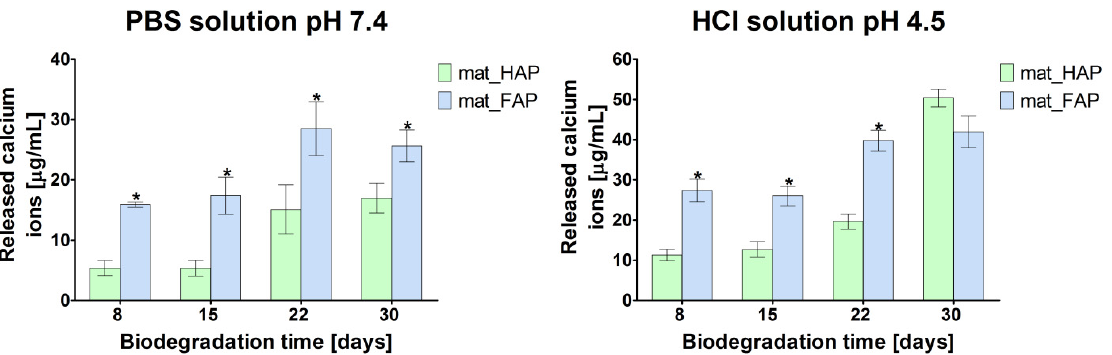
Figure 3. Evaluation of biomaterials’ biodegradation in a physiological (phosphate-buffered saline (PBS)) and in an acidic environment (HCl solution), mimicking the osteoclast-mediated bone resorption process, assessed by analysis of released calcium ions (degradation product of apatite-based biomaterials) (* statistically significant results compared to mat_HAP; p < 0.05, unpaired t - test).